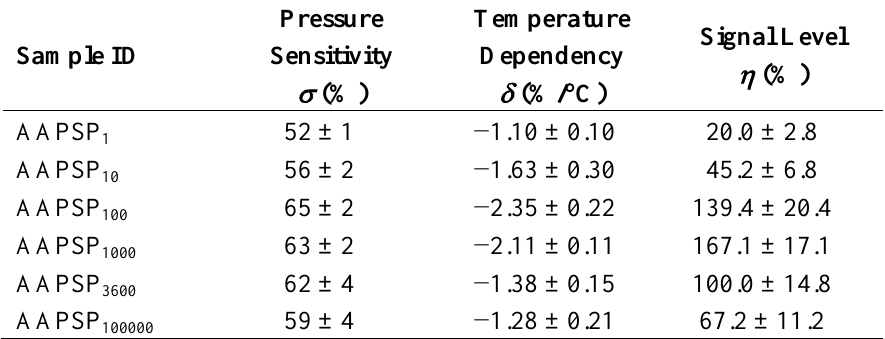
Table 2. Summary of AA-PSP characterizations. The error was determined as the standard deviation of the three data sets from the same dipping procedures.